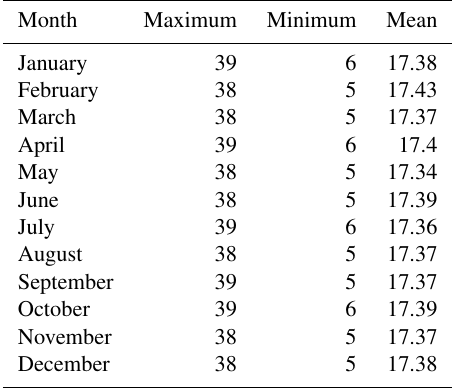
Table 10. The number of AGRI selected stars in every month.